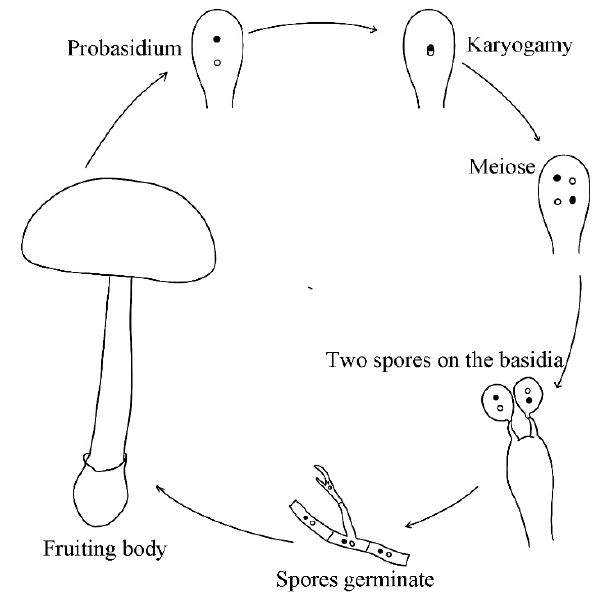
Figure 6. A proposed model for the most likely mode of reproduction for A. exitialis in